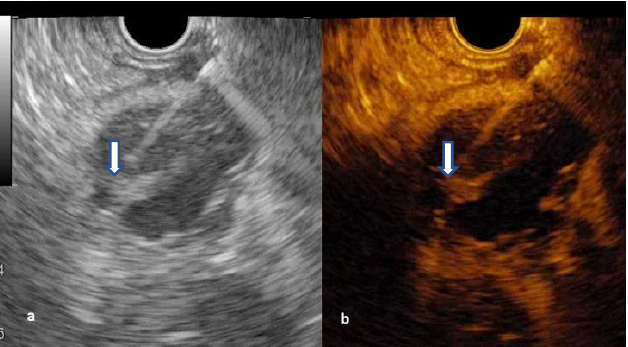
Figure 4. Walled-off pancreatic necrosis with an unenhanced solid component (arrow): ( a ) B-mode EUS; ( b ) Contrast-enhanced EUS .